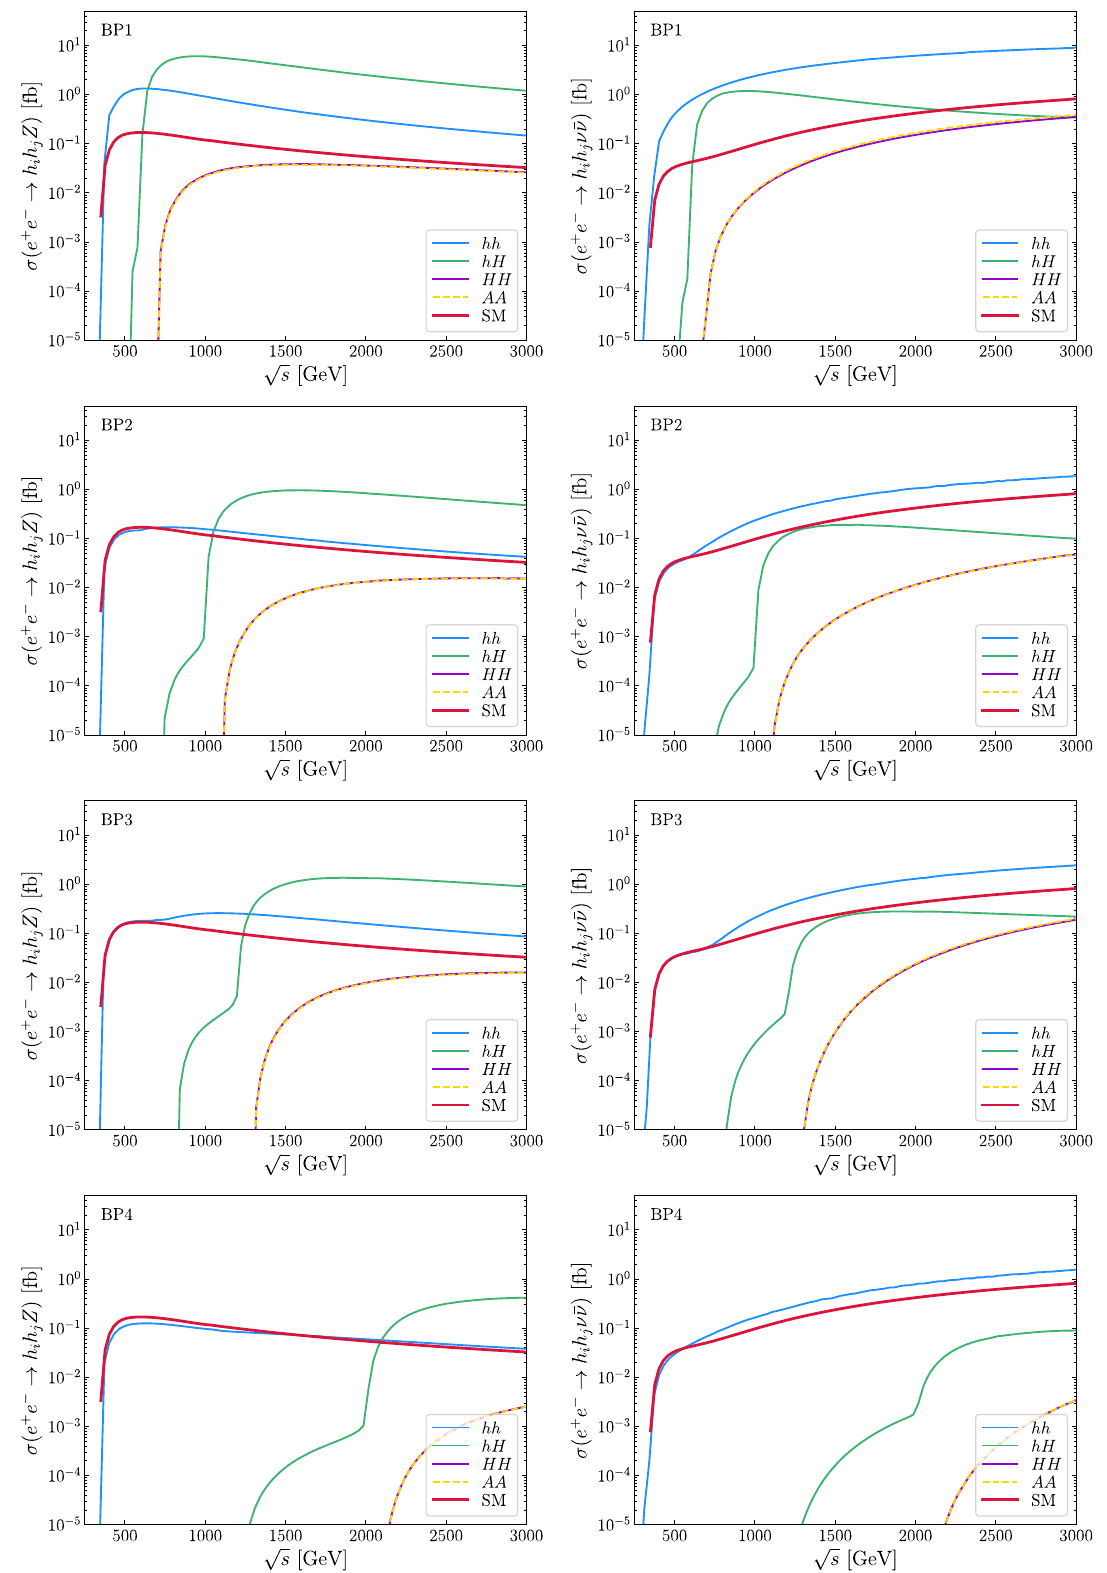
√ s for the processes e + e − → h i h j Z (left) and e + e − → h i h j ν ¯ ν (right) for